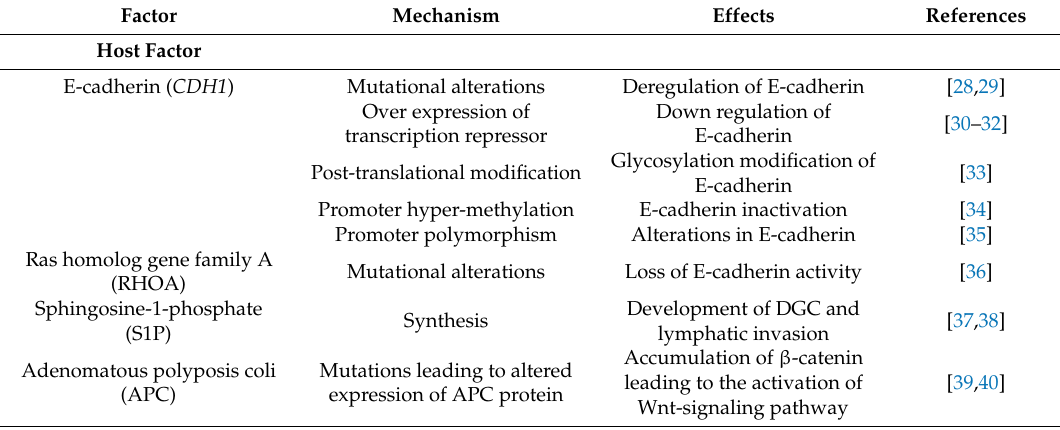
Table 1. Contributing factors for pathogenicity of diffuse type gastric cancer